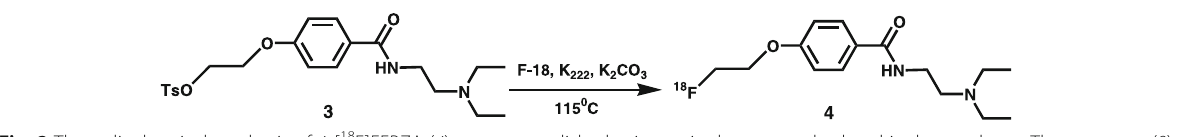
Fig. 2 The radiochemical synthesis of 4-[ 18 F]FEBZA ( 4 ) was accomplished using a single-step method and is shown above. The precursor ( 3 ) was reacted with F-18 fluoride in kryptofix/K 2 CO 3 and the crude reaction mixture was subsequently purified using HPLC